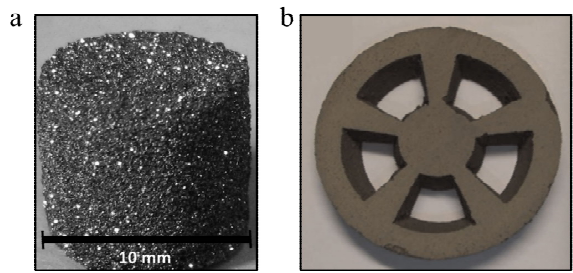
Fig. 16 3DP of SiC ceramic: (a) Porous SiC ceramic. Reproduced with permission from Ref. [61], © Göller Verlag 2015. (b) SiC nw /Si 3 N 4 ceramic. Reproduced with permission from Ref. [62], © Elsevier B.V. GmbH